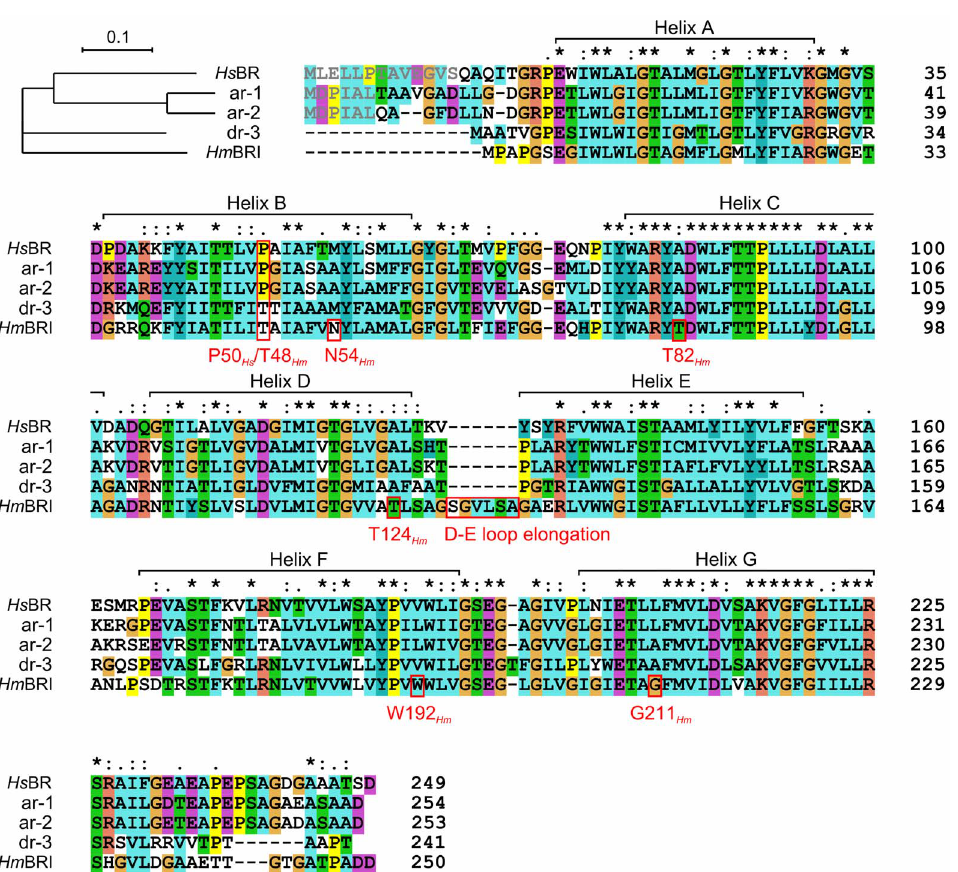
Figure 5. Phylogenetic tree and sequence alignment of Hs BR, ar-1, ar-2, dr-3 and Hm BRI. The unique Hm BRI D-E loop elongation, the residues that result in novel inter-helical hydrogen bonds, and the P50 Hs /T48 Hm position are highlighted. The propeptide residues that are cleaved in the mature protein in vivo are shown in grey. The asterisk indicates the fully conserved residues, the colon and period indicate conservation between groups of strongly similar properties scoring . 0.5 and ,5 0.5 correspondingly in the Gonnet PAM 250 matrix